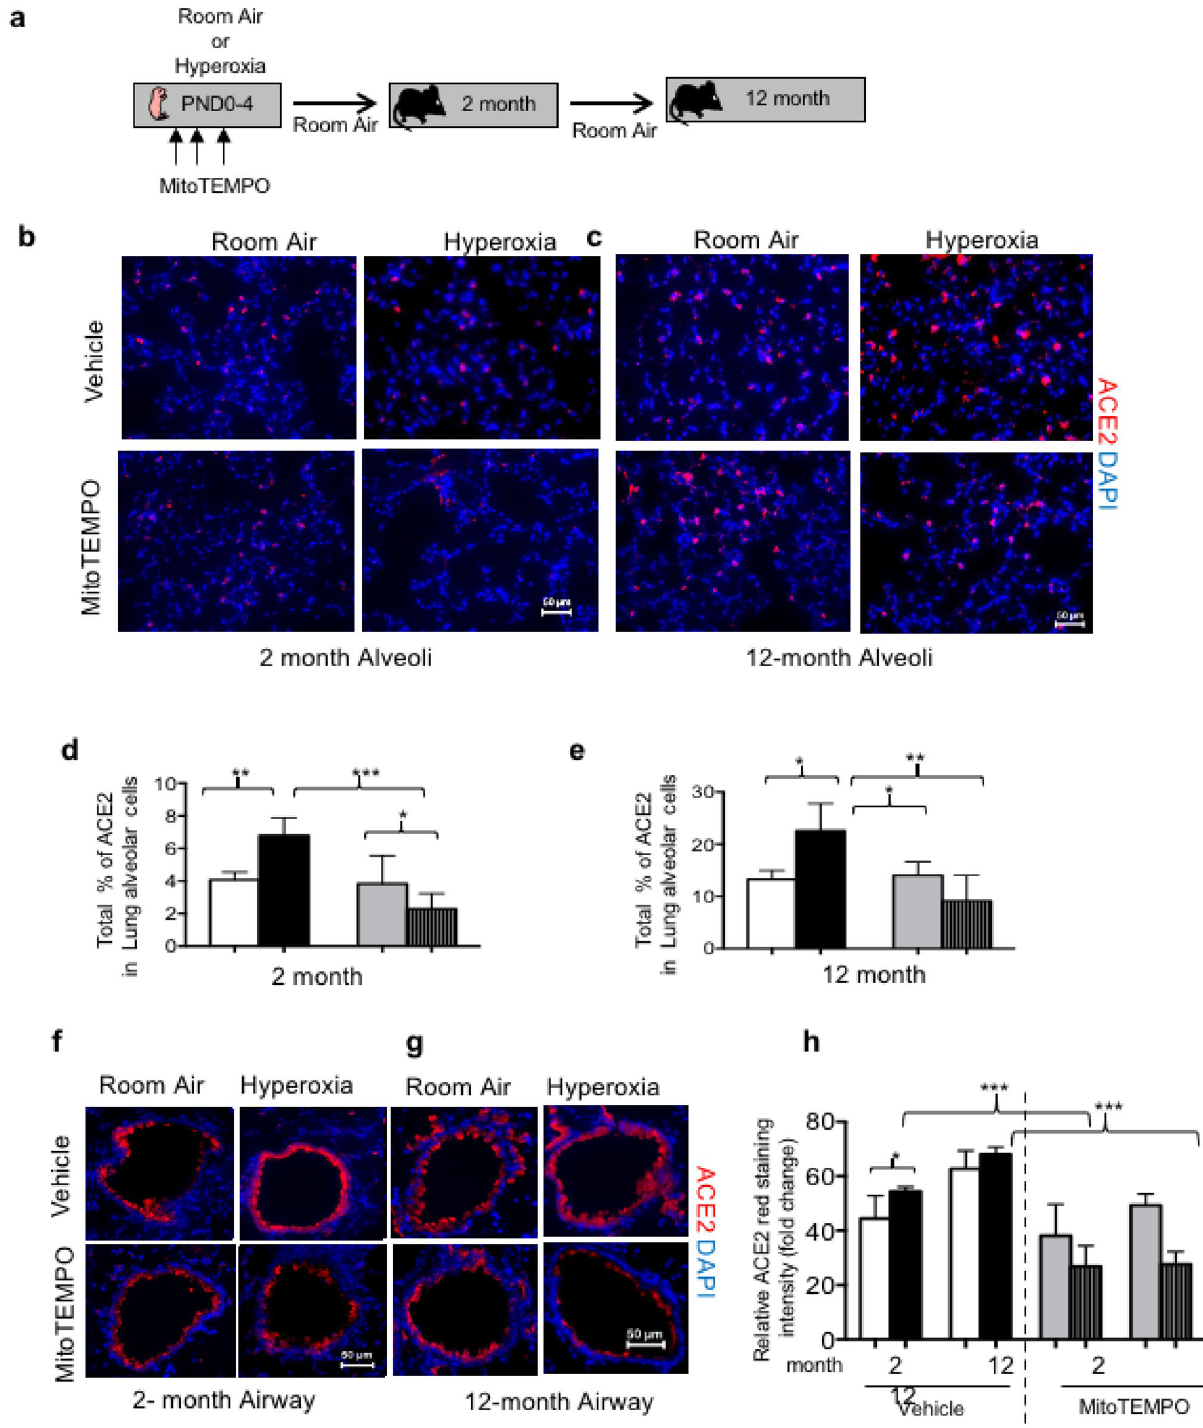
Figure 5. Anti-oxidants prevent hyperoxia from stimulating expression of ACE2. ( a ) Cartoon showing the experimental approach of exposing newborn mice to hyperoxia and treated with mitoTEMPO (PND0-4). ( b ) Alveolar regions of 2-month and 12-month mice were stained for ACE2 (red), and counterstained with DAPI (blue). ( c ) The proportion of ACE2 positive cells to total DAPI positive cells were quantified in 5 random images from 5 mice per group and graphed. ( d ) Airways of 2-month and 12-month mice were stained for ACE2 (red), and counterstained with DAPI (blue). ( e ) Staining intensity of ACE2 was determined from 5 random airway images of 5 mice per group using identical exposure time. Scale bar = 50 μm; Statistical significance is comparisons for all pairs using Tukey–Kramer HSD test with *P ≤ 0.05; **P ≤ 0.01; ***P ≤